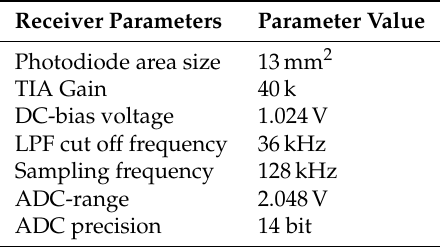
Table 2. Parameters of the VLP receiver in the experimental